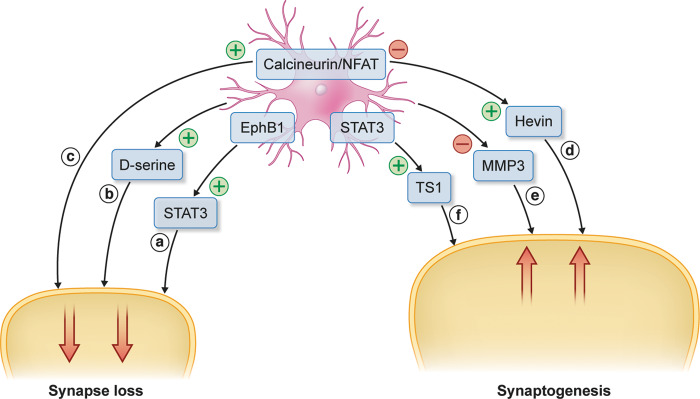

Role of astrocytes in post-traumatic synapse loss and repair. The upregulation of astrocytic ephrin B1 and STAT3 phosphorylation following TBI have been found to coincide with a decrease in VGlut1 (a) (Nikolakopoulou et al., 2016). The tonic release of astrocytic d-serine has been associated with synapse damage after TBI (b) (Perez et al., 2017). Astrocytic calcineurin/NFAT signalling pathway induces synaptic strength loss in CA1 and a reduction in synaptic protein loss (PSD95 and GluR1) (c) (Furman et al., 2016). MMP3 has been implicated in maladaptive synaptic recovery after TBI (e) (Falo et al., 2006). Hevin has been shown to promote post-traumatic synaptogenesis which was amplified by the blockade of the calcineurin/NFAT pathway (d) (Furman et al., 2016). Thrombospondin 1 (which is regulated by STAT3) has been found to promote synapse recovery after motor neuron injury (f) (Tyzack et al., 2014).